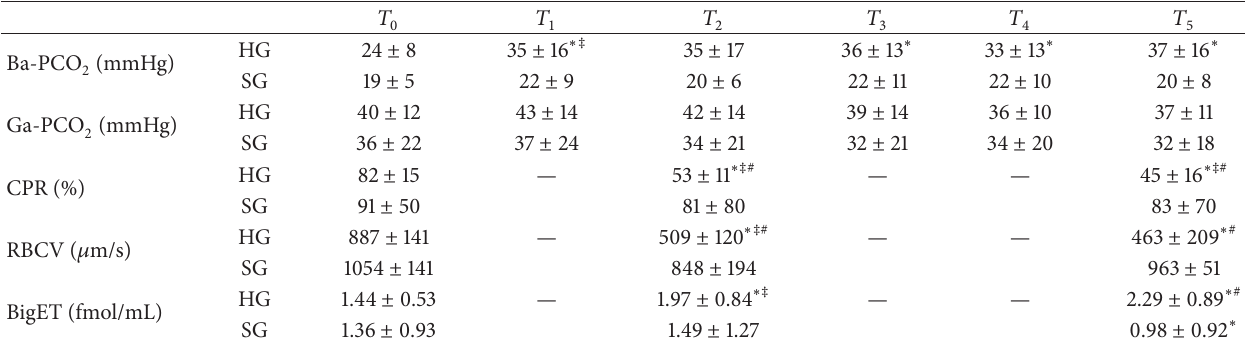
Table 4: Changes in